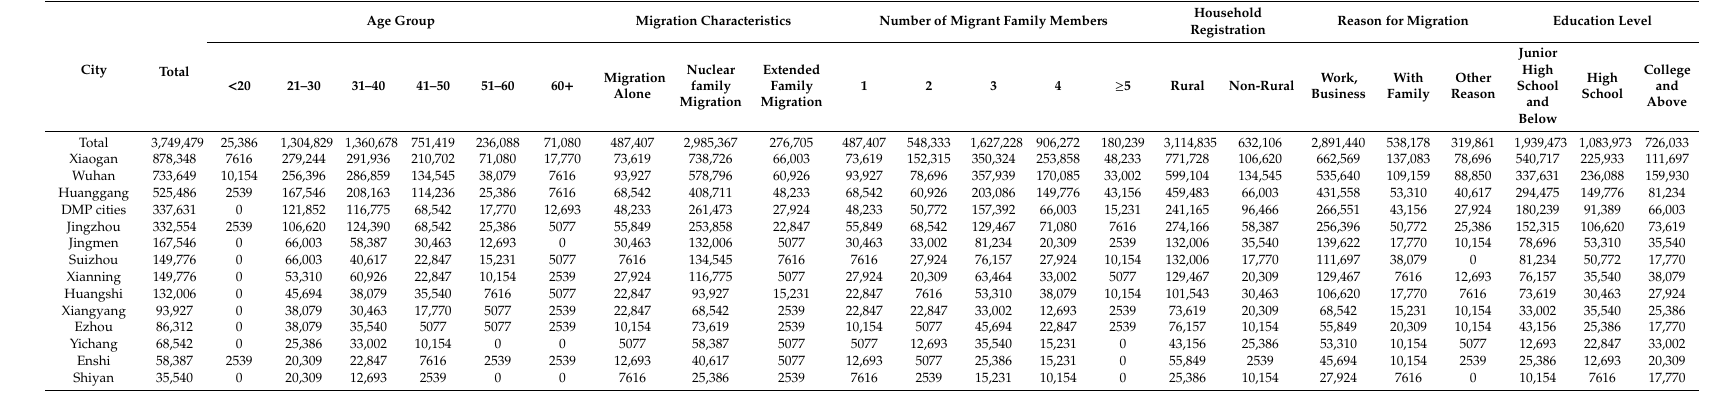
Table 8. Joint distribution of Wuhan floating population in Hubei